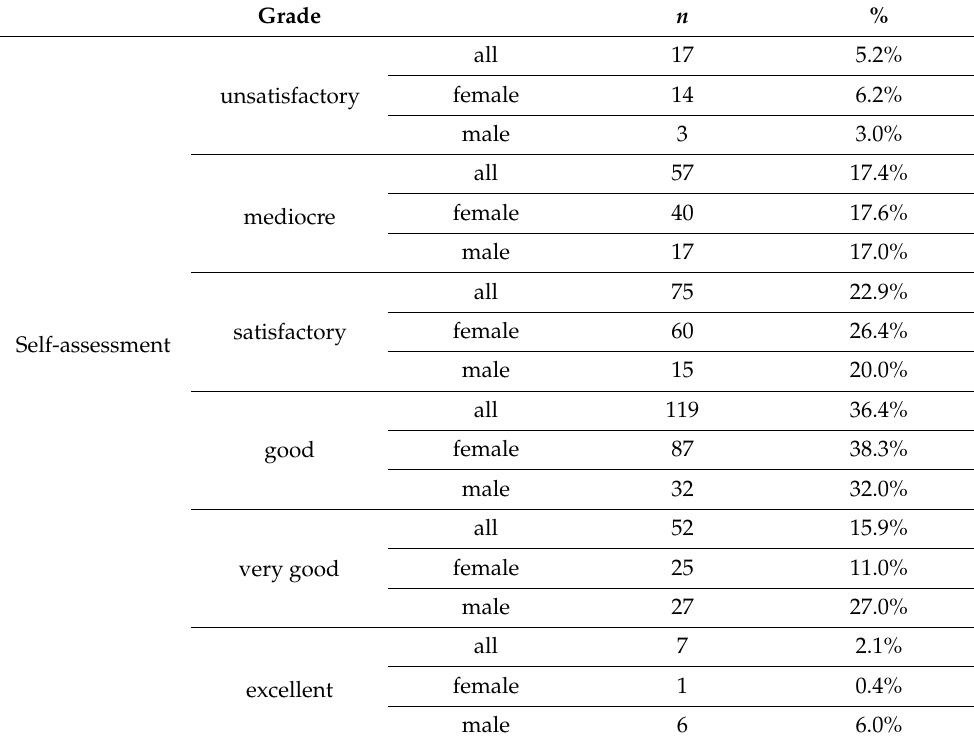
Table 2. Self-assessment of students’ knowledge about hypertension: distribution of grades ( n = 327). Grade n